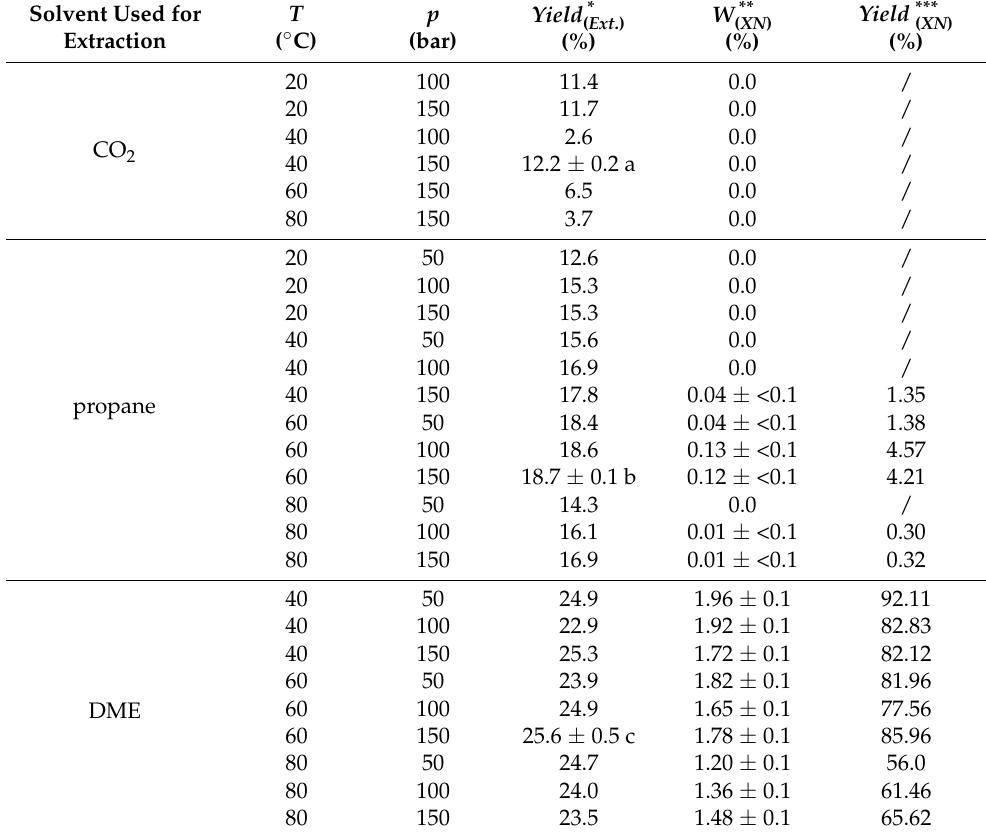
Table 2. Yield of extracted Xanthohumol and its concentration in the extracts expressed in weight % (mean ± SD) prepared by using CO 2 , propane and DME. (Limit of quantification, LOQ = 0.1%). Solvent Used for